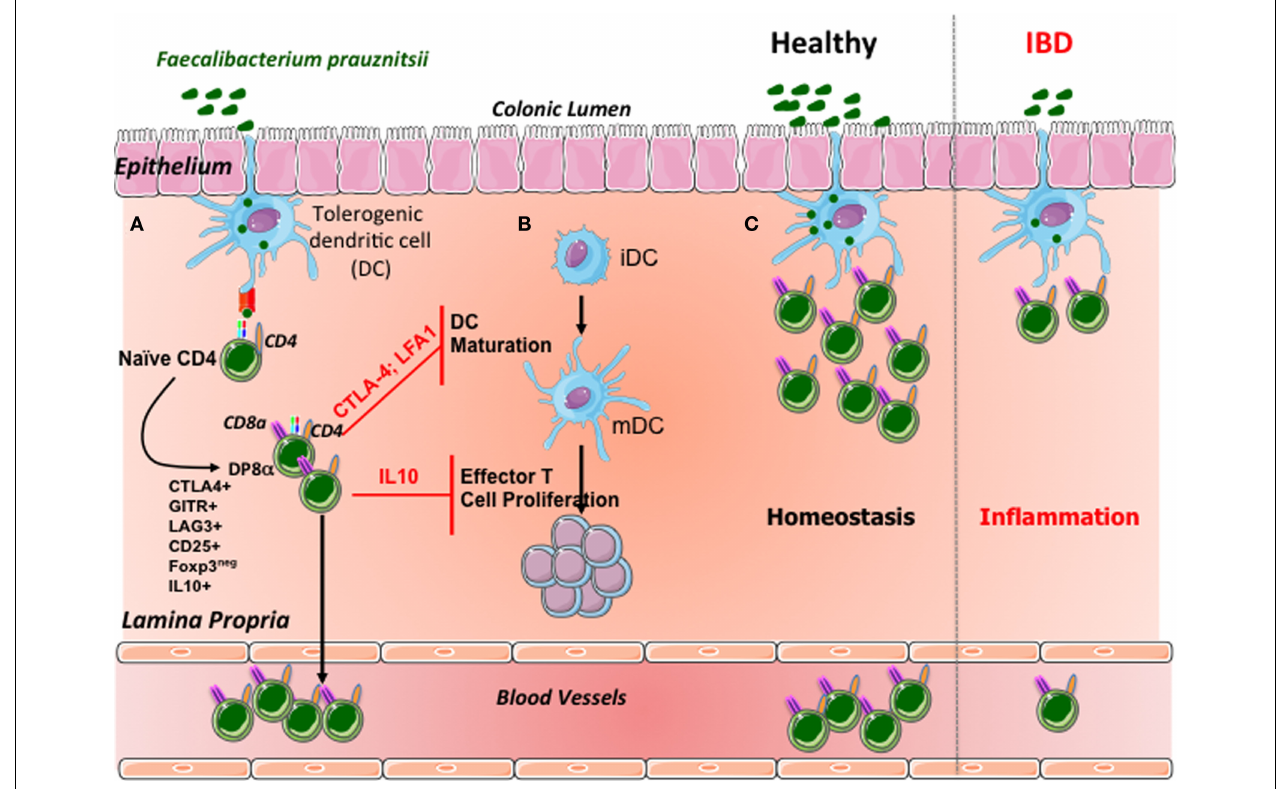
FIGURE 2 | Suggested model of DP8 ααα Treg induction and homeostasis control in the human colonic mucosa . (A) In the colonic mucosa, F. prausnitzii antigens are presented by dendritic cells. Simultaneously, these bacteria may imprint a tolerogenic phenotype on dendritic cells. The recognition of F. prausnitzii antigens by the naïve CD4 T cells equipped with a specific TCR contributes, in this context, to the differentiation of these cells into Foxp3-lacking Tregs coexpressing CD4 and CD8 α . DP8 α T lymphocytes express most of the regulatory markers of Foxp3 Tregs and secrete IL-10. A fraction of these cells migrate into the blood. (B) Like Foxp3 Tregs, DP8 α Tregs inhibit the maturation of dendritic cells in a CTLA-4- and LFA-1-dependent manner. Moreover, these cells decrease effector T-cell proliferation, via a mechanism involving interleukin 10. (C) Under normal circumstances, colonic F. prausnitzii expands the pool of DP8 α Tregs in the colonic mucosa and in the blood; in IBD patients, the low levels of F. prausnitzii may compromise the expansion or survival of the DP8 α Treg population, reducing the frequency of these cells in the mucosa and blood of